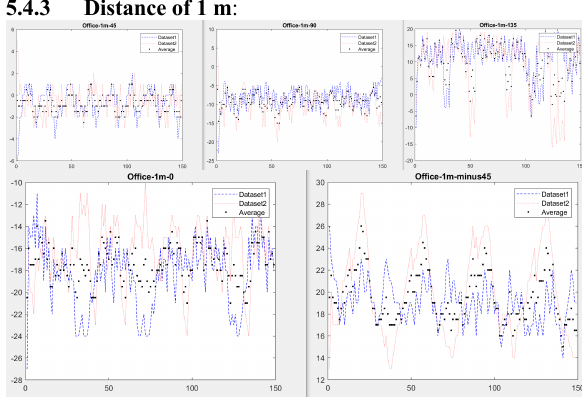
Figure 15 . A further average error plot including more angles at the distance of 1 m.